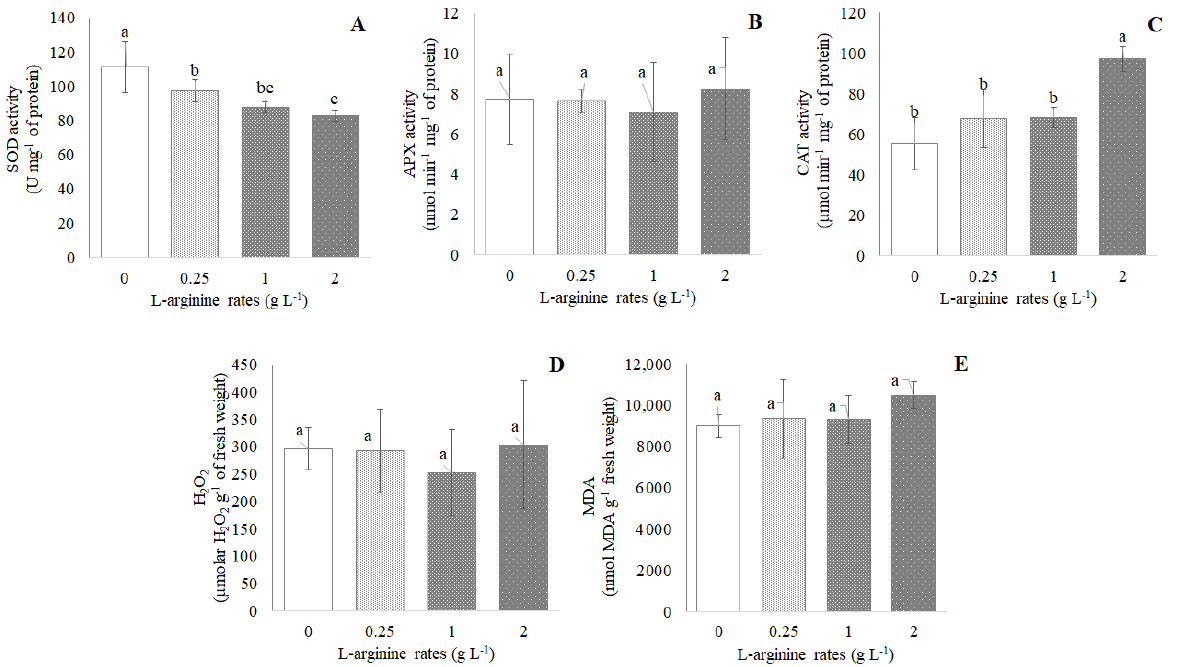
Figure 1. ( A ) Superoxide dismutase activity (U mg −1 of protein); ( B ) ascorbate peroxidase activity (nmol min −1 mg −1 of protein); ( C ) catalase activity (µmol min −1 mg −1 of protein); ( D ) hydrogen peroxide content (µmolar H 2 O 2 g −1 of fresh weight); and ( E ) lipidic peroxidation (nmol MDA g −1 of fresh weight) from ora-pro-nobis leaves in function of different rates of L-arginine exogenous application. Data followed by the same letter did not differ from each other by Tukey range test at p ≤ 0.05.